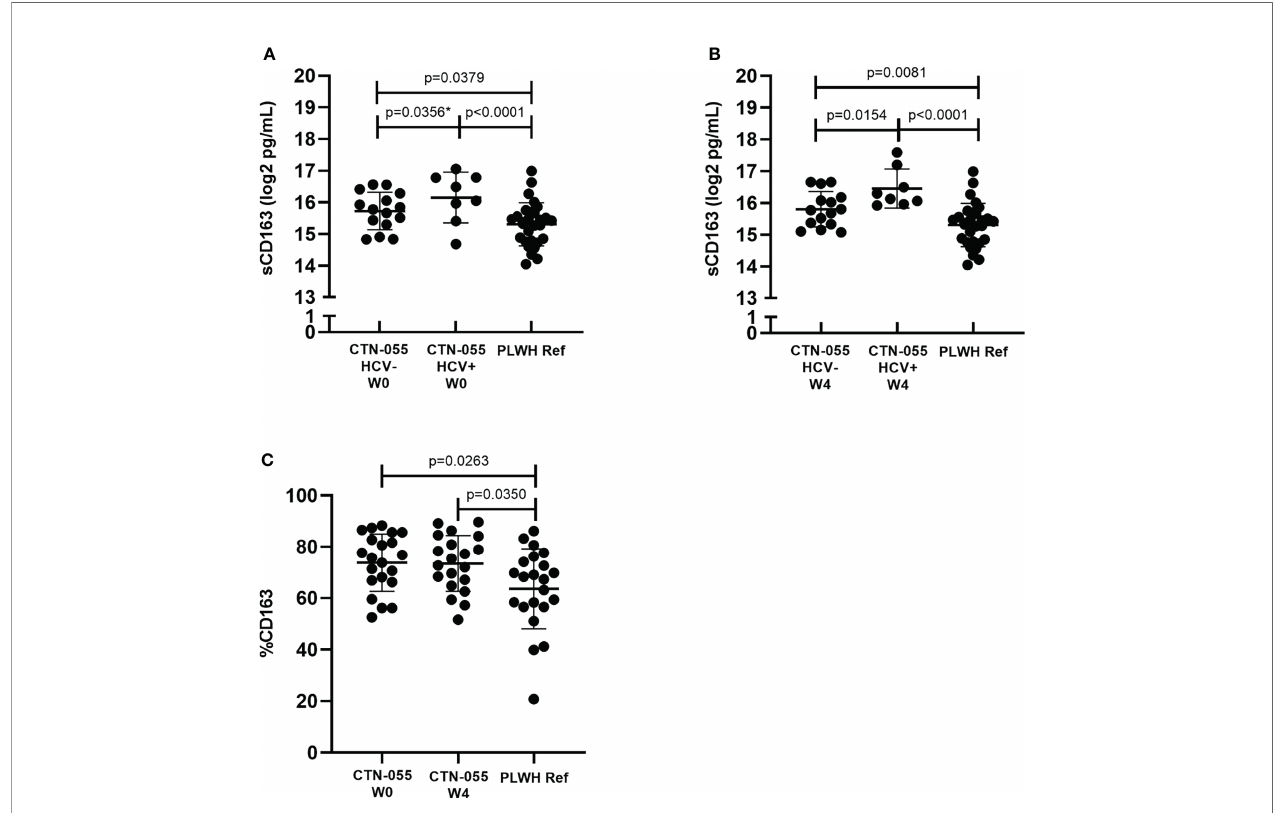
FIGURE 1 | Alcohol-use disorder is associated with alterations in cell-surface and soluble CD163 Among PLWH. Soluble CD163 was quanti fi ed by ELISA in plasma collected from CTN-055 participants at W0 ( A ; n = 23) and W4 ( B ; n = 23) timepoints, and PLWH ref. population (n = 29) at study enrollment. Shown are log2 transformed data, with means and SD. CD163 expression was analyzed on CD14 + monocytes using fl ow cytometry among CTN-055 participants at W0 (n = 21) and W4 (n = 20), and PLWH ref. population (n = 22) at study enrollment; shown are means with SD of total CD14 + CD163 + monocytes (C) . *indicates unadjusted p-value.